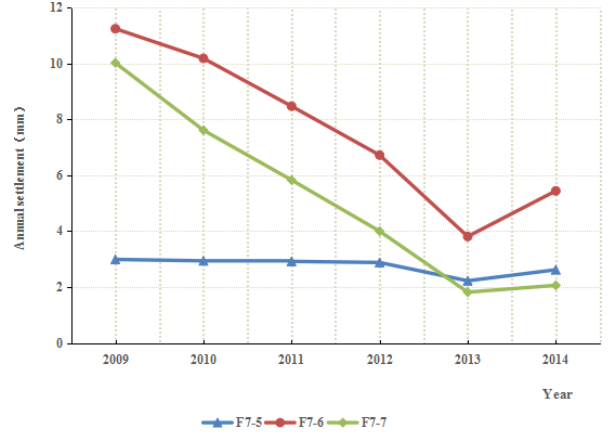
Figure 4. Annual settlement change curve of layerwise marks in the deep layer (2009–2014).